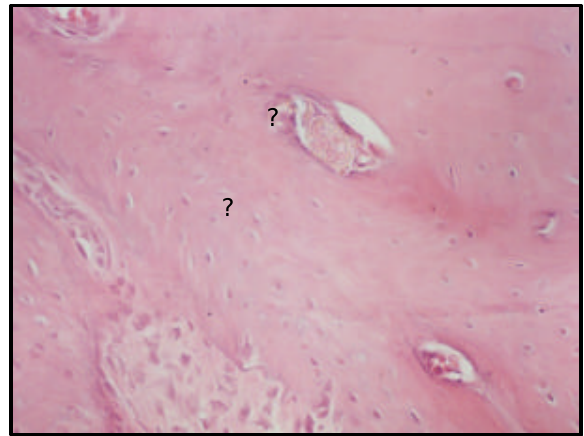
FIGURA 4 - Tecido ósseo maduro ( ? ) rodeando um pequeno fragmento do polímero de mamona ( ? ). HE 450x